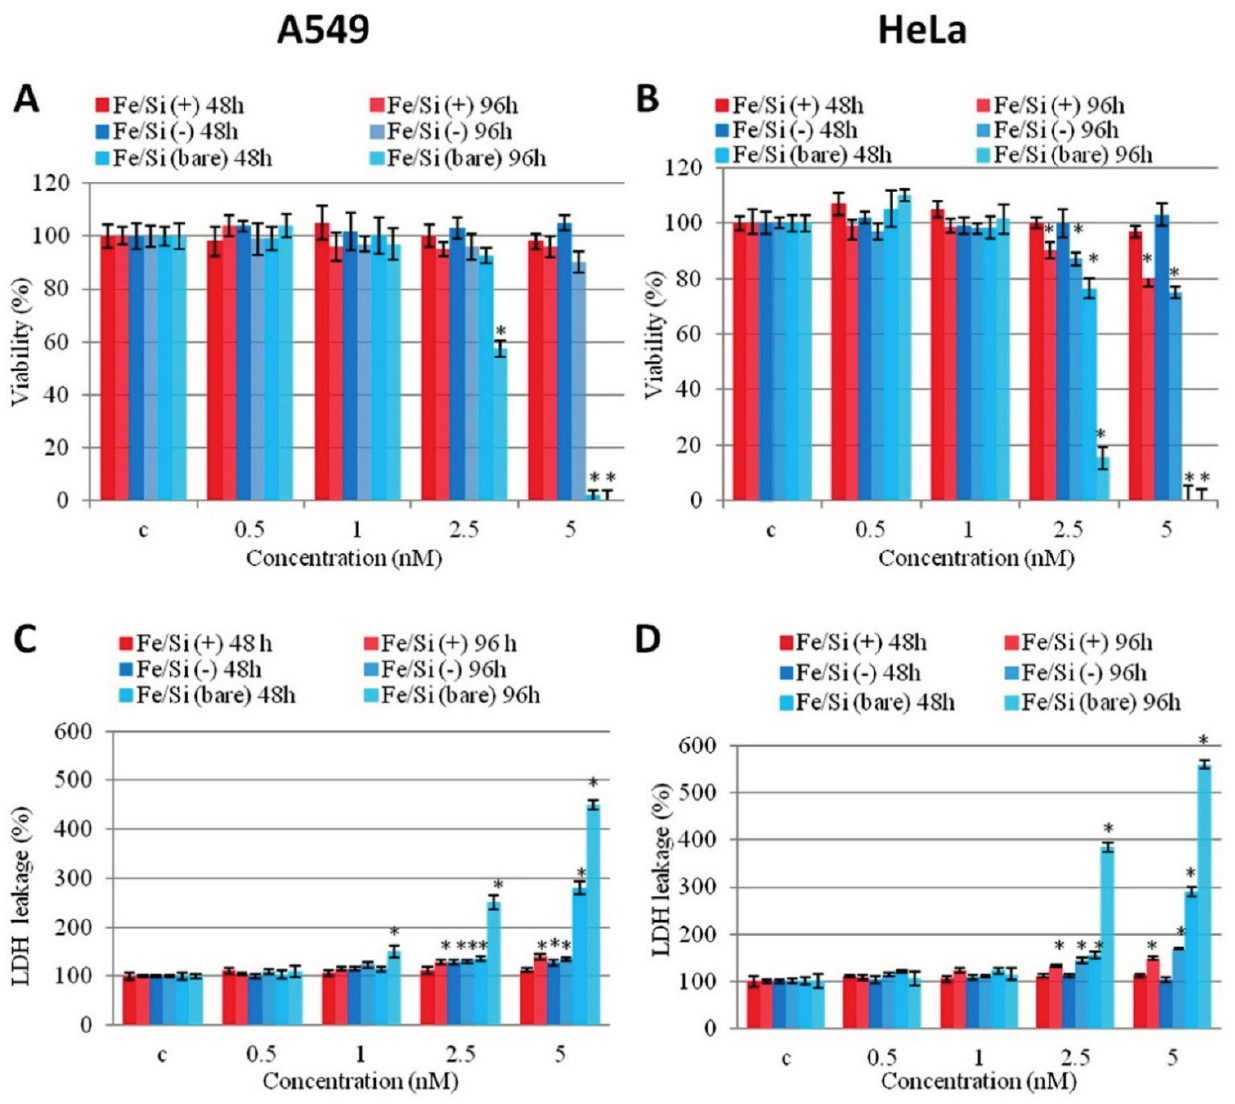
Figure 1. Effect of bare and passivated Fe 3 O 4 /SiO 2 nanoparticles (NPs) on the viability and membrane damage in two cell lines (A549 and HeLa). ( A , B ) (2-(2-Methoxy-4-nitrophenyl)- 3-(4-nitrophenyl)-5-(2,4-disulfophenyl)-2 H -tetrazolium (WST-8) proliferation assay and ( C , D ) Lactate dehydrogenase (LDH) assay on A549 and HeLa cells incubated with increasing concentrations (0.5, 1, 2.5, 5 nM) of bare and passivated Fe 3 O 4 /SiO 2 NPs at different times (48 and 96 h). c identifies the negative control in the absence of NPs. Viability of NPs-treated cells is expressed relative to non-treated control cells. As positive control (P) cells were incubated with 5% dimethyl sulfoxide (DMSO) in WST-8 assay and 0.9% Triton X-100 in LDH assay (not shown). Data are reported as mean ± SD from three independent experiments; * p < 0.05 compared with control ( n = 8). Reprinted